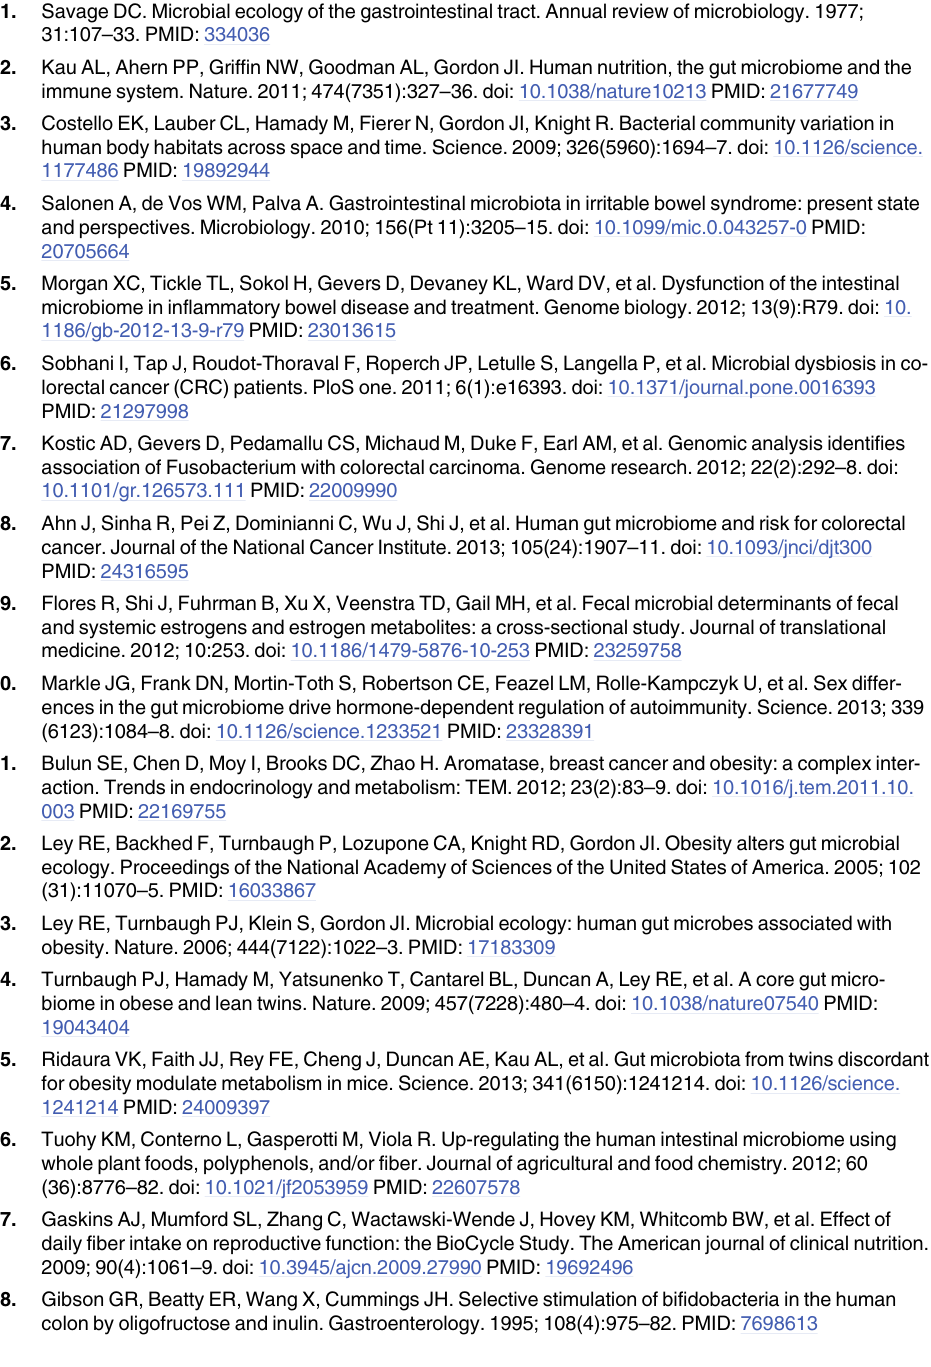
PLOS ONE | DOI:10.1371/journal.pone.0124599 April 15,